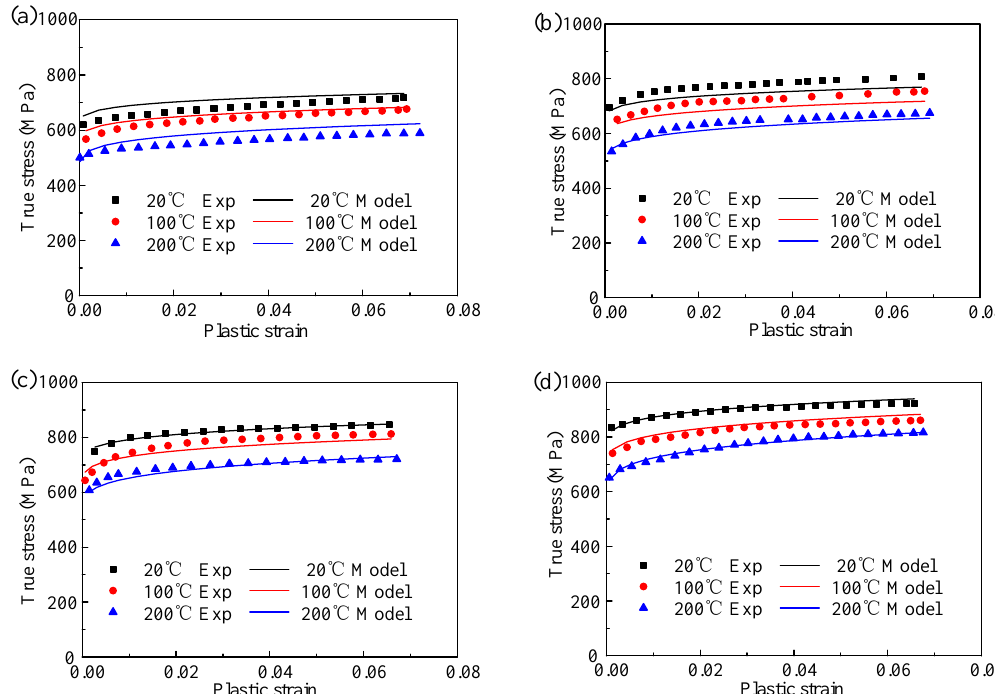
Figure 8. Comparison between experiment result and the predicted flow stress by KL model at di ff erent strain rate of ( a ) 0.001 s − 1 , ( b )1000 s − 1 , ( c ) 3000 s − 1 , and ( d ) 5000 s − 1 . Table 4. The optimized material constants of KL model.